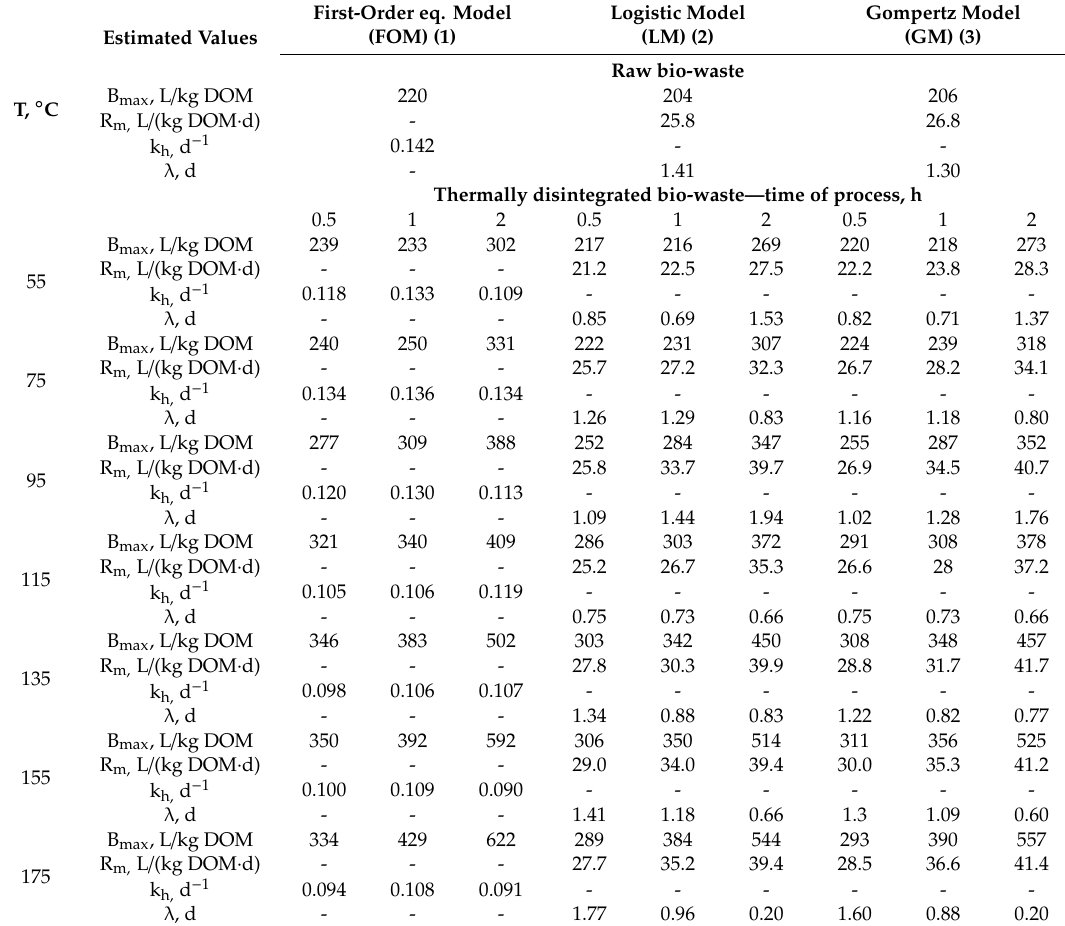
Table 5. Estimated values of parameters for three analyzed methane fermentation models for raw and thermally disintegrated